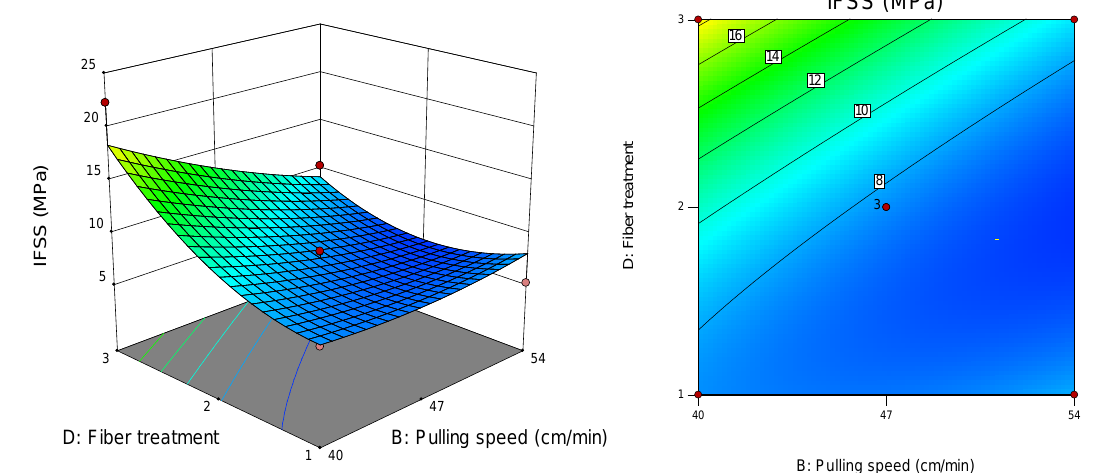
ff ect between fibre treatment and pulling speed on IFSS. Figure 14. Interaction effect between fibre treatment and pulling speed on IFSS. Figure 14. Interaction e